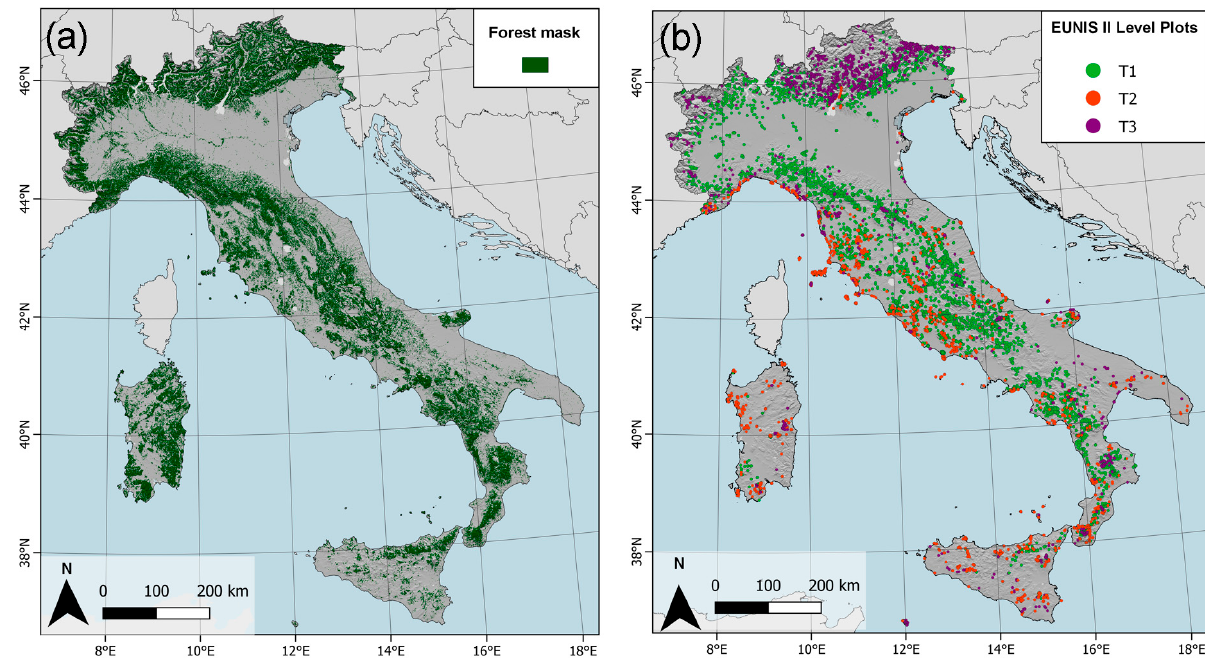
Figure 3. ( a ) Forest cover area corresponding to the forest mask produced in the ancillary data; ( b ) Spatial distribution of vegetation habitat dataset categorized in EUNIS II hierarchical level (T1: broadleaved deciduous; T2: broadleaved evergreen; and, T3: needleleaved forest habitat-type).